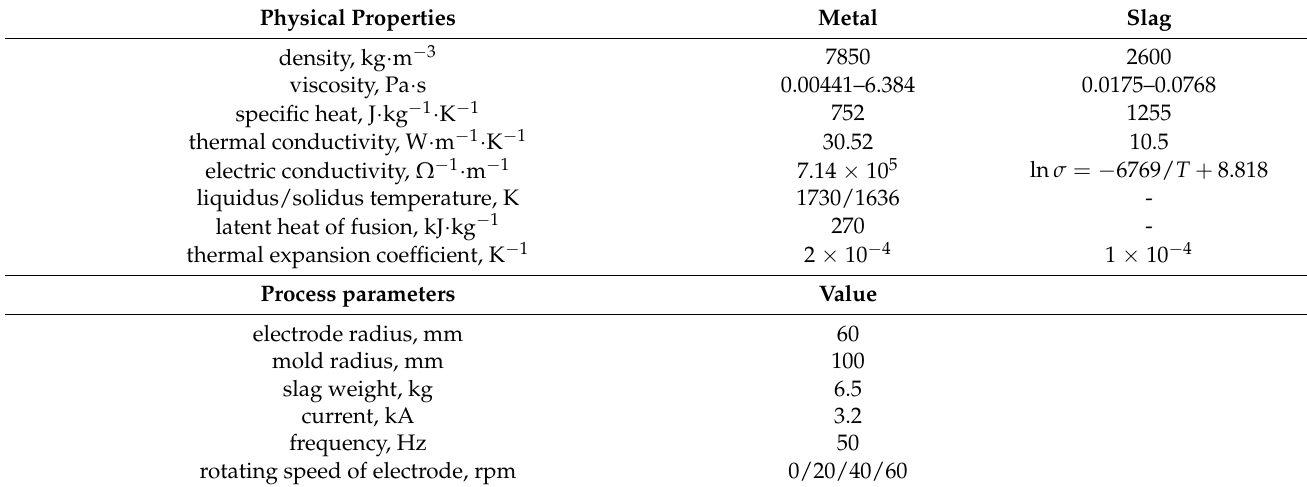
Table 2. Physical properties and process parameters.